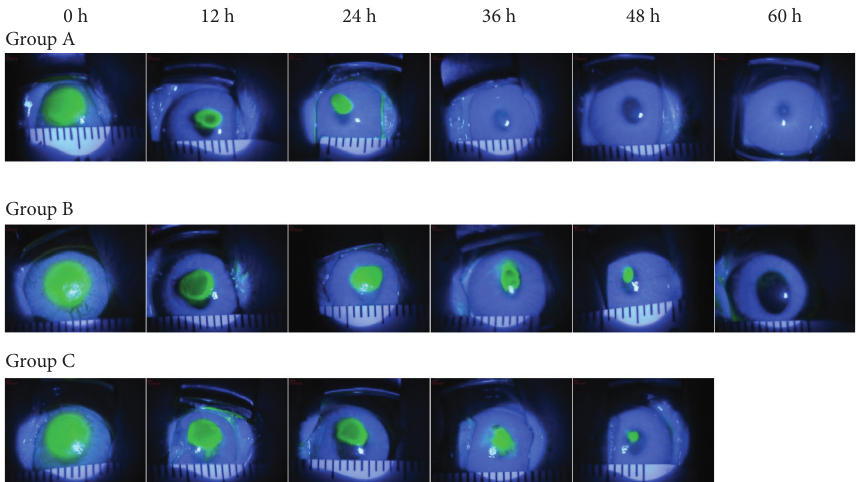
Figure 1: The fluorescence staining of corneal epithelium in each group at different time points shows that in groups A, B, and C, the area of fluorescence staining on the cornea was the same at 0h, when the experiment was initiated, but at 12h and 24 h after intervention, the area of fluorescence staining in group A was significantly smaller than that of group B and group C. At 36 h, filamentous fluorescence staining was only seen in the center of the cornea, and the surrounding cornea tissue was transparent. At 48h, no corneal fluorescence staining was found, indicating that the corneal epithelium was completely healed. In group B, the area of corneal fluorescence staining was larger than that of group A but smaller than that of group C at all time points except at 0h. In group C, the area of fluorescent staining was the largest among all three groups at all time points. After 72h of intervention, filamentous fluorescence staining still could be seen, indicating that corneal epithelium was rough and not completely healed.